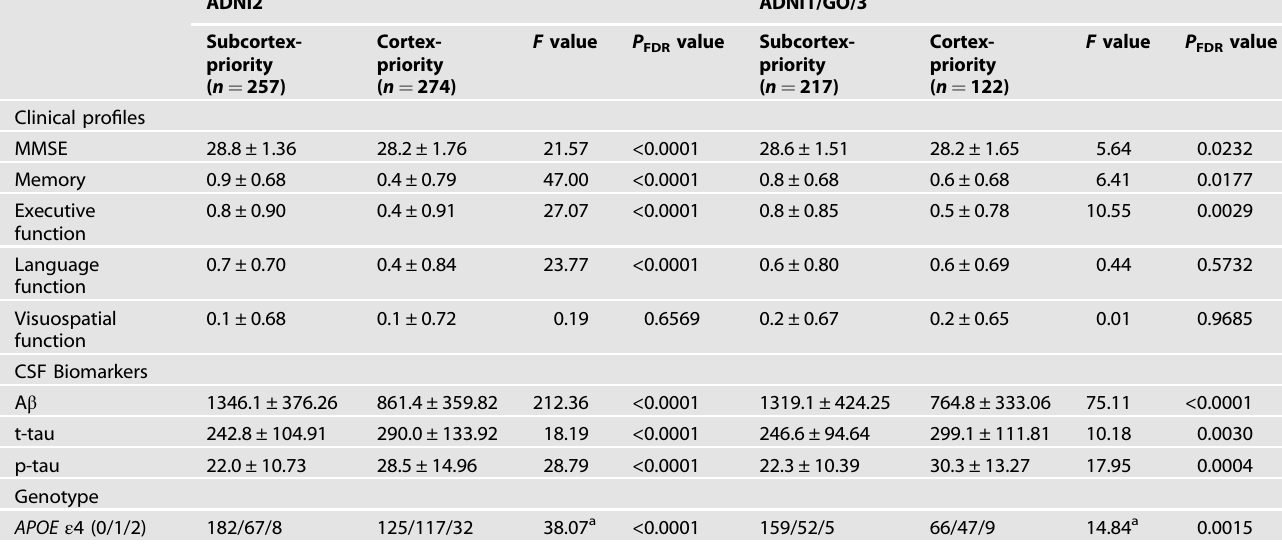
Table 2. Clinical, CSF biomarker, and genetic comparisons between